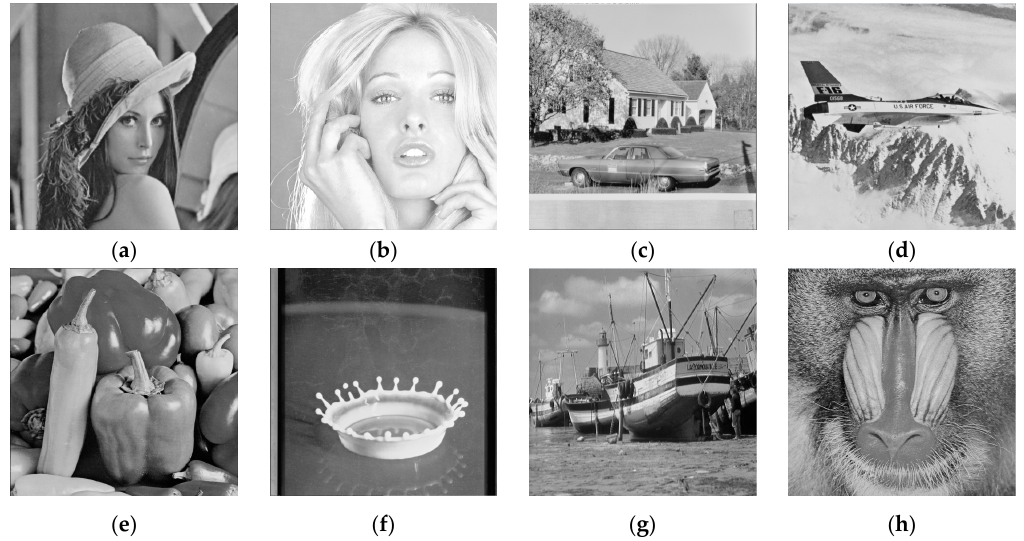
Figure 5. Eight test images. ( a ) Lena; ( b ) Tiffany; ( c ) House; ( d ) Jet; ( e ) Peppers; ( f ) Splash; ( g ) Boat; ( h ) Baboon.